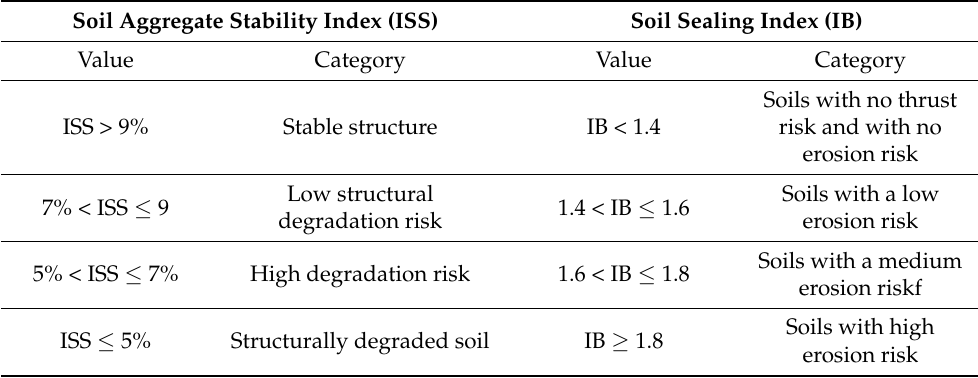
Table 1. Interpretation of soil categories according to the Soil Aggregate Stability Index (ISS),